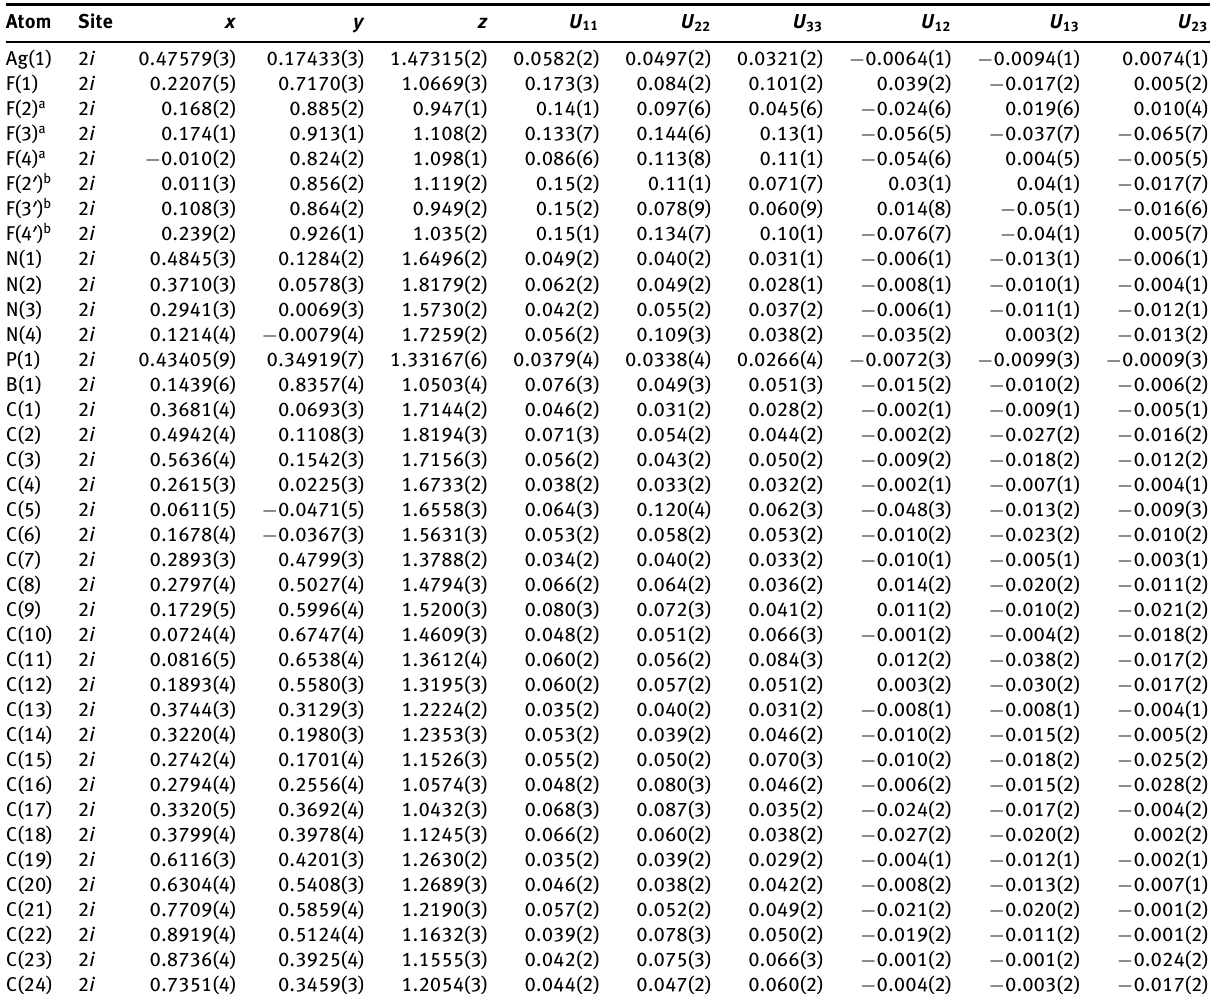
Table 3: Fractional atomic coordinate and displacement parameters (Å 2